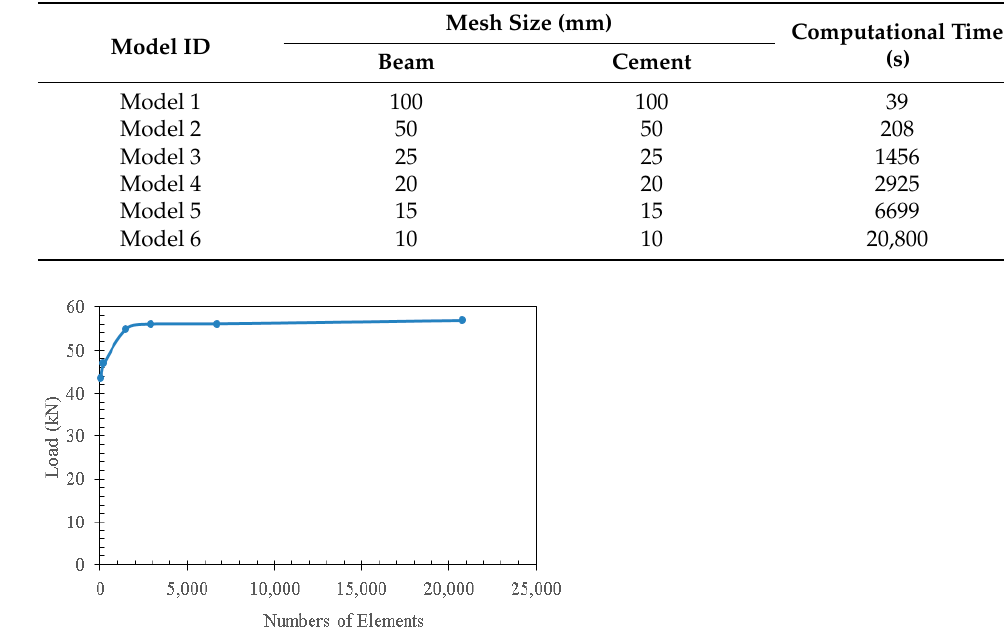
Table 4. Mesh size sensitivity analysis.